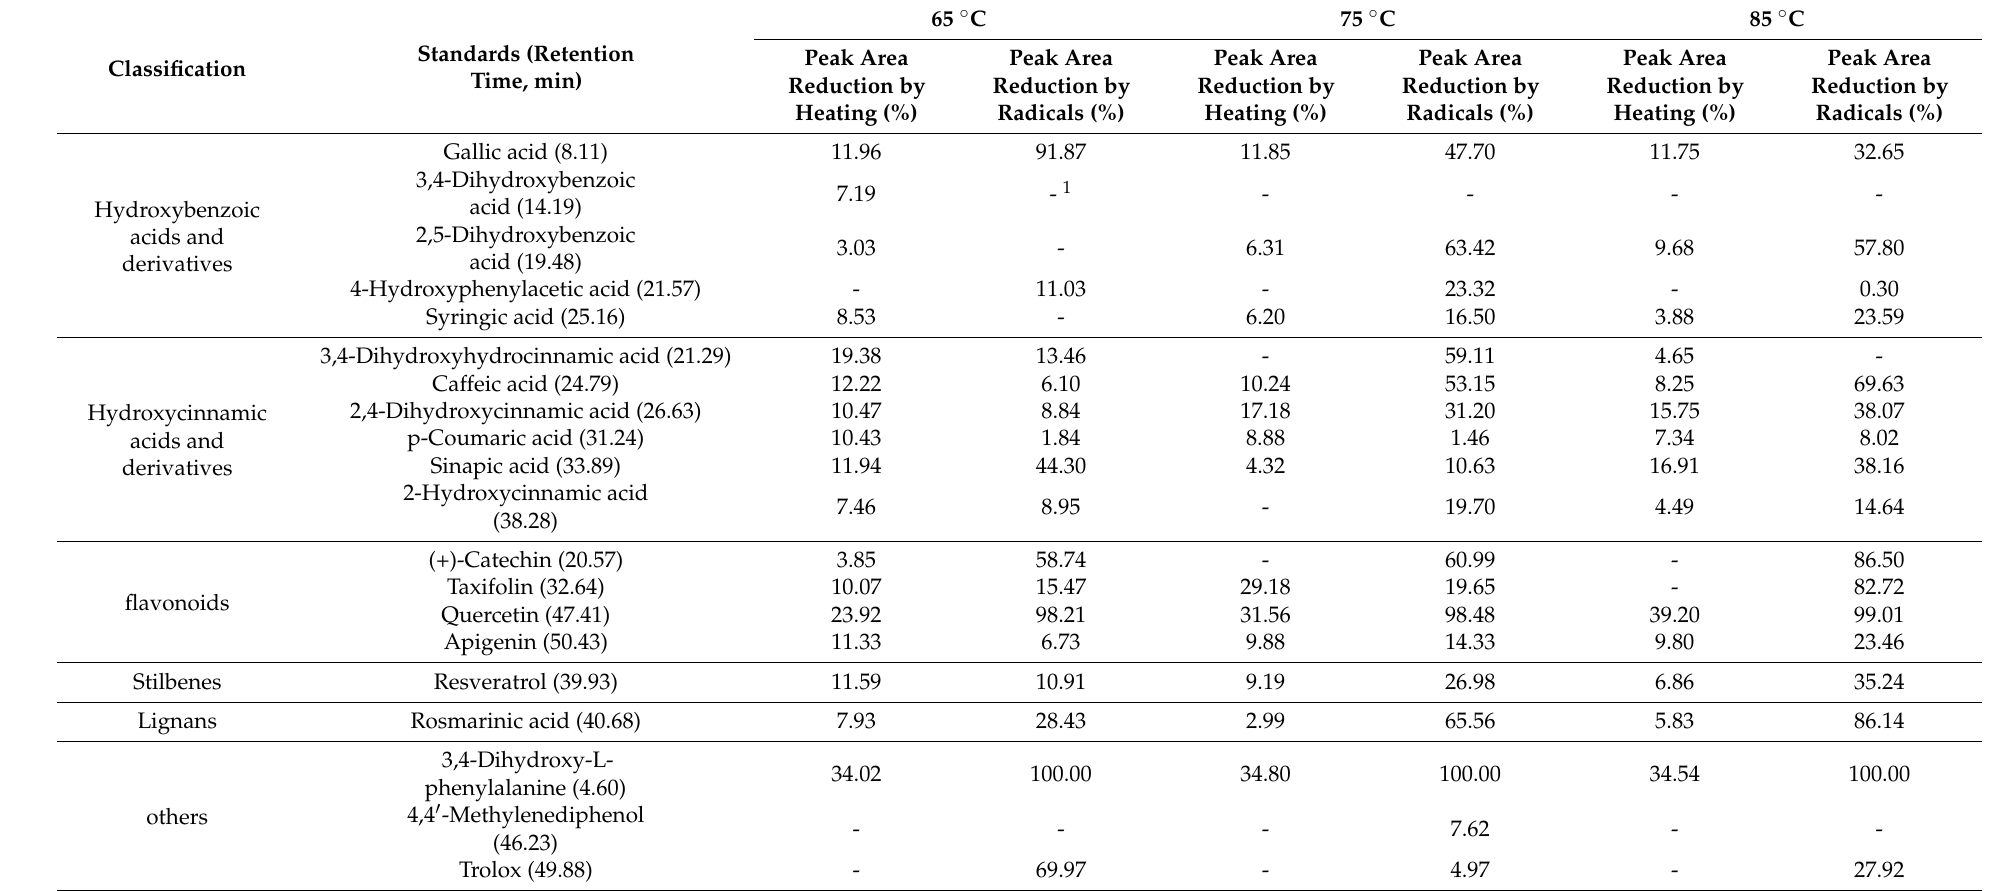
Table 1. Peak area reduction of polyphenols at different temperatures and results of screening antioxidants based on AAPH